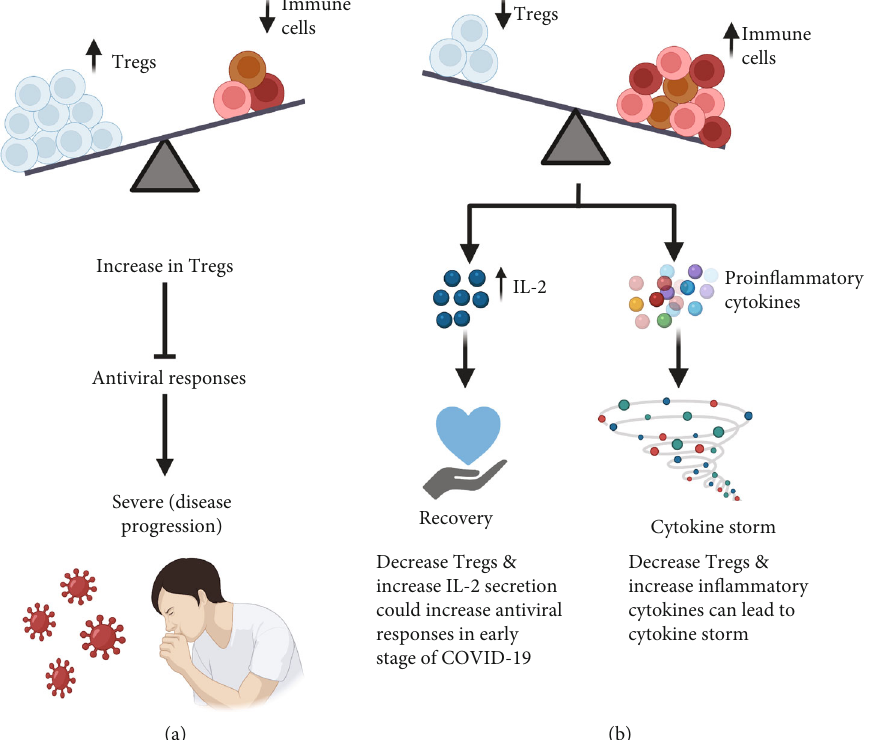
Figure 1: Role of Tregs in COVID-19 patients: An increase in level of Tregs could play a negative role in COVID-19 patients by inhibiting antiviral T cell responses, resulting in the progression of COVID-19 disease (a). A decrease in level of Tregs could result in cytokine storm or recovery depending on the response of proin fl ammatory cytokines. Firstly, early increase in IL-2 could be associated with faster viral clearance and early immune response in asymptomatic COVID-19 patients. Secondly, the signi fi cant increase in T helper cells such as Th17 could be related to hyperin fl ammation and progression of COVID-19 disease